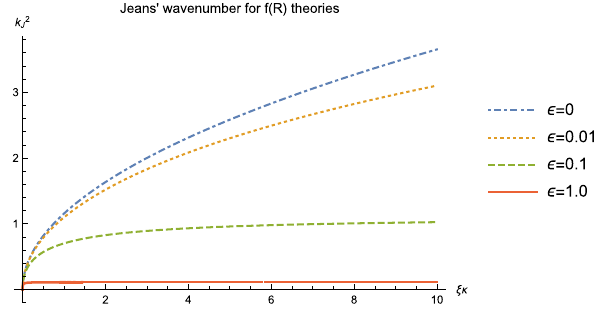
Fig. 1 Behavior of the squared modified Jeans wavenumber in f(R) theories as a function of the system parameter ξκ in the limit α → −∞ for different values of